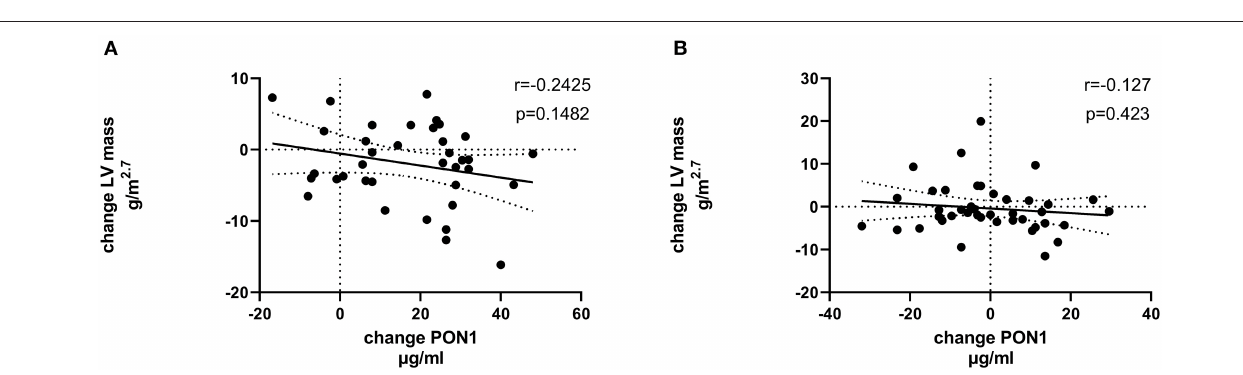
FIGURE 4 | Change in LV mass vs. change in PON1 mass. (A) Transplant group. (B) Dialysis group.